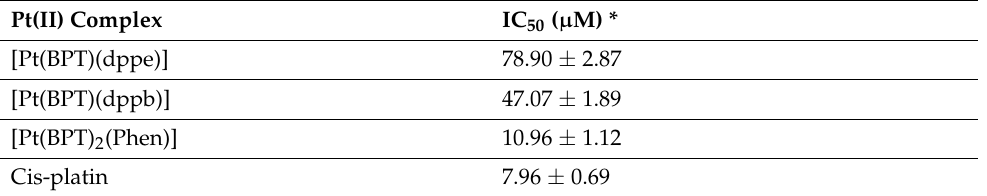
Table 5. The IC 50 values of the tested complexes against MCF-7 cancer